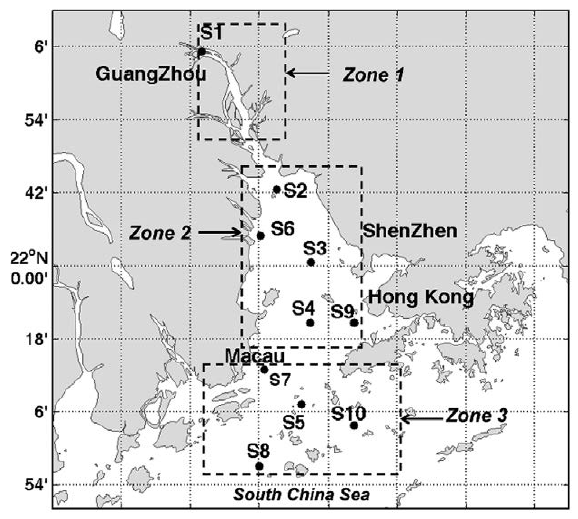
Fig. 1. – Sampling sites in the Pearl River